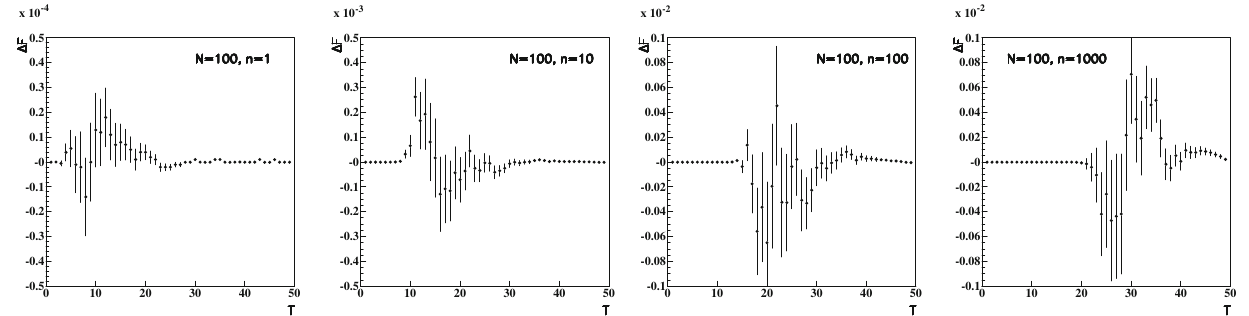
Fig. 5 First column: the difference between the exact calculation for F ( T | 100 ) and the scaling equation 21 for F ( T | 2 · 50 ) is shown in the upper panel, while the lower panel shows the fractional error in the p value as a function of the p value. For the remaining plots, we compare F ( T | n · 100 ) with F ( T | 2 n · 50 ) .Secondcolumn: n = 10.Thirdcolumn: